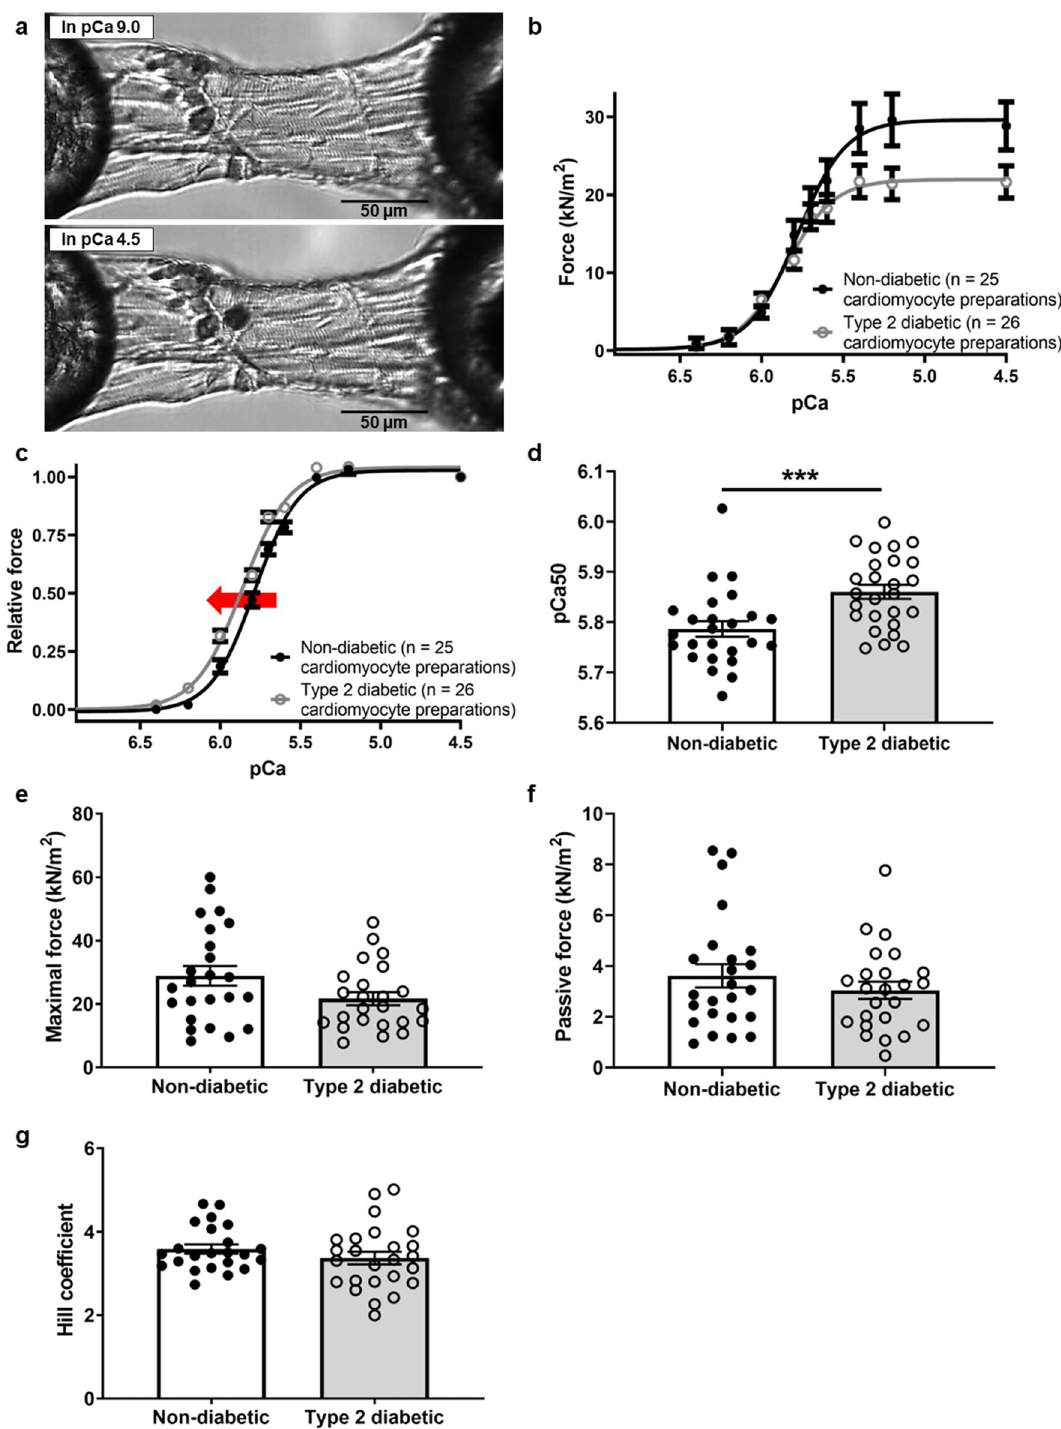
Figure 1. Force-pCa measurements on skinned rat cardiomyocyte preparations. ( a ) A representative photomicrograph of a 10x-magnified skinned rat cardiomyocyte preparation mounted on the experimental apparatus and bathed in relaxing solution pCa 9.0 and maximally activating solution pCa 4.5. ( b ) Absolute force-pCa curves of non-diabetic (n = 5 animals) and diabetic (n = 5 animals) cardiomyocyte preparations. ( c ) Average pooled relative force-pCa relationships of non-diabetic and diabetic cardiomyocyte preparations at a sarcomere length of 2.2 µm. The red arrow indicates a leftward shift of the force-pCa curve in the diabetic cardiomyocyte preparations. ( d ) pCa50, ( e ) maximal force per cross sectional area, ( f ) passive force per cross sectional area, and ( g ) Hill coefficient of individual left ventricular skinned cardiomyocyte preparations isolated from the non-diabetic and type 2 diabetic rat hearts. Data are presented as means ± SEM, *** P < 0.001 versus non-diabetics, unpaired